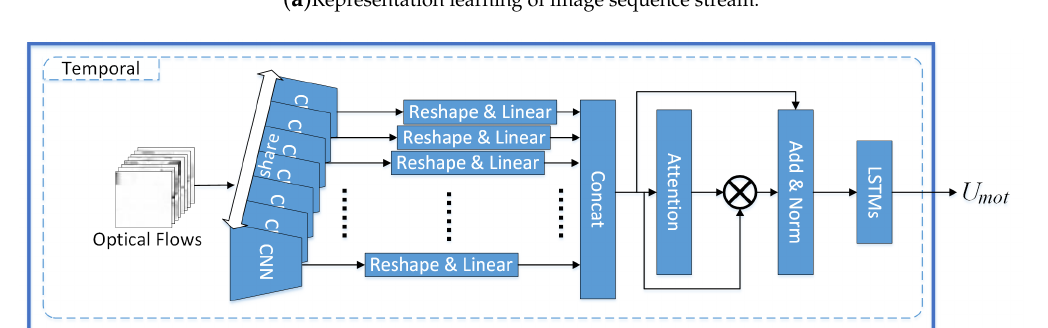
( b ) Representation learning of optical flow stream. Figure 3. Action-level representation